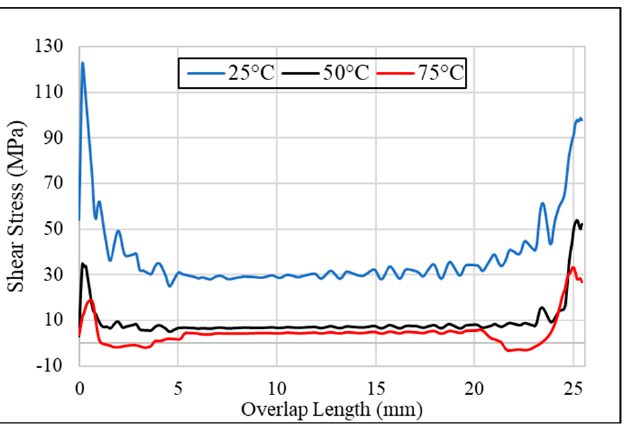
Figure 10. Shear stress distribution at location A of SLJ with neat adhesive at different temperatures.